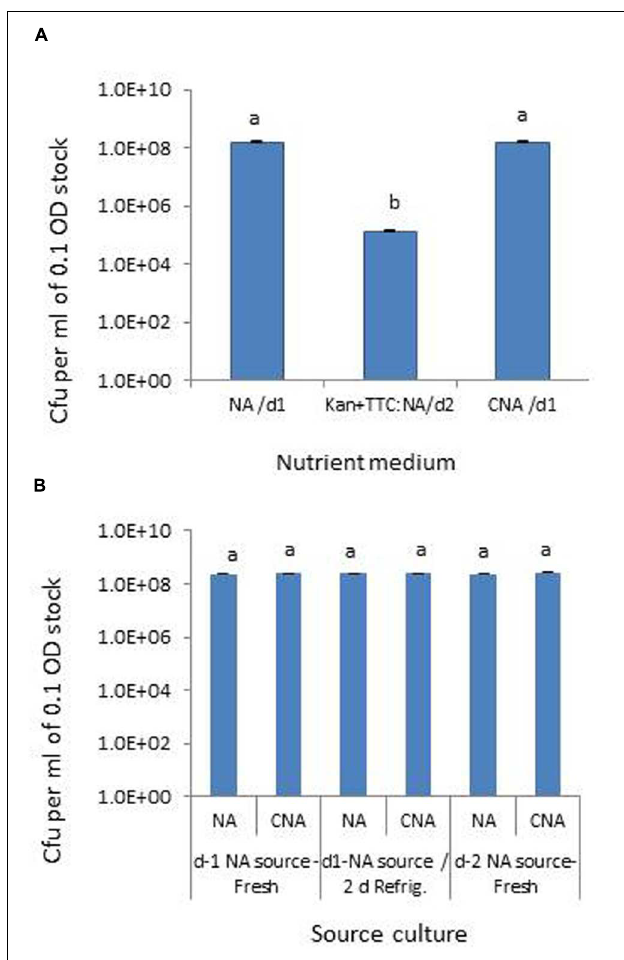
FIGURE 1 | Assessing different media for the selective monitoring of Pseudomonas aeruginosa ( Pau ) based on cfu ml − 1 of 0.1 OD anchored stock (A) and testing of source Pau cultures of different ages for cell viability based on cfu (B). NA/d1 and CNA/d1 in (A) indicate cfu recorded on respective media on day-1 and Kan + TTC:NA/d2 cfu observed on day-2. Vertical bars indicate standard deviation. Bars with same letters are not significantly different at P =